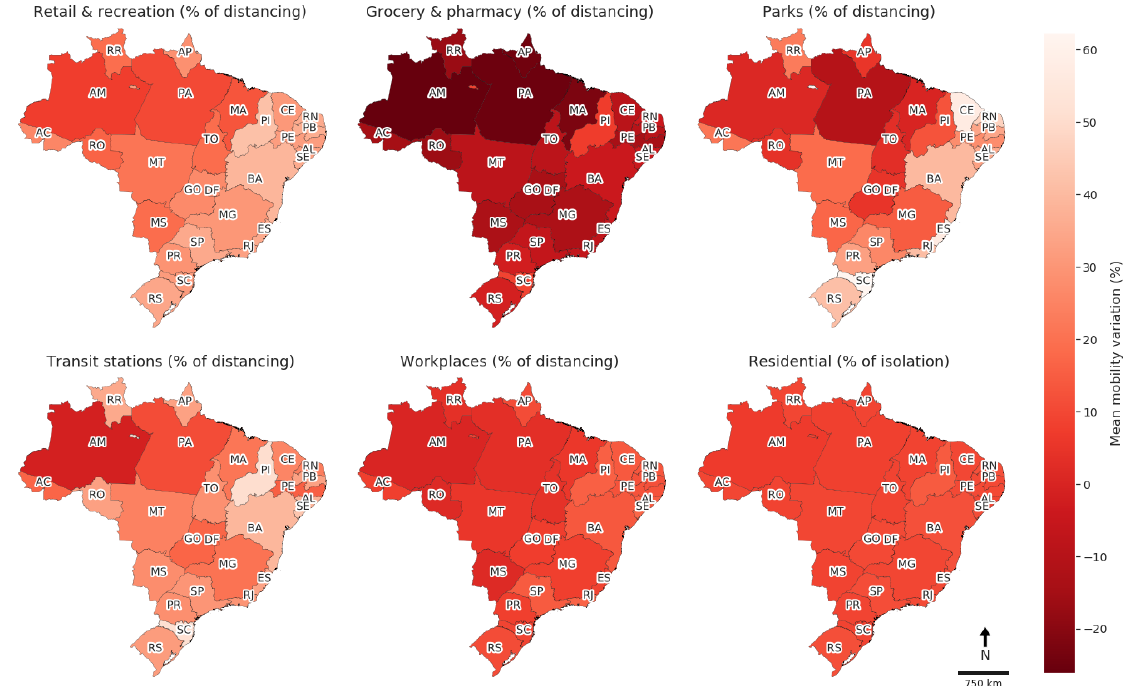
Figure 16. Average variation of mobility from baseline (3 January to 6 February 2020) for the states of Brazil during the period from 1 June to 27 October 2020. Lighter colours indicate greater distancing or greater isolation in residential areas. Source of basic data: Covid-19 Community Mobility Reports,